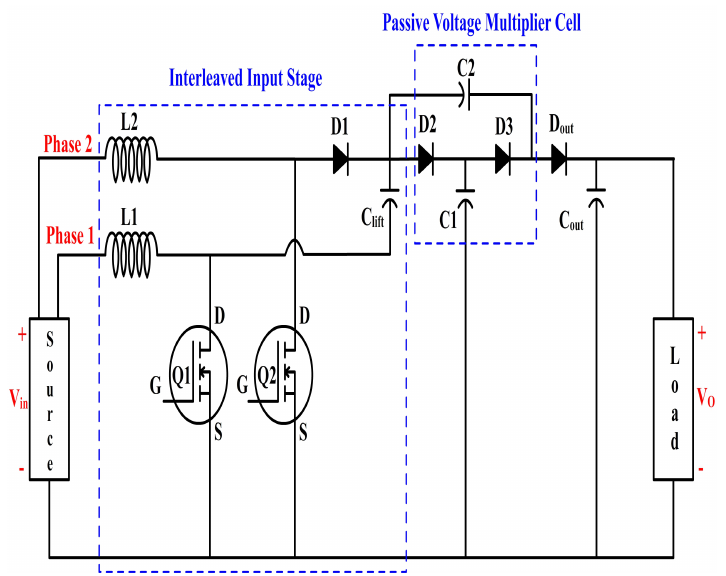
Figure 1. Proposed non-isolated interleaved hybrid boost